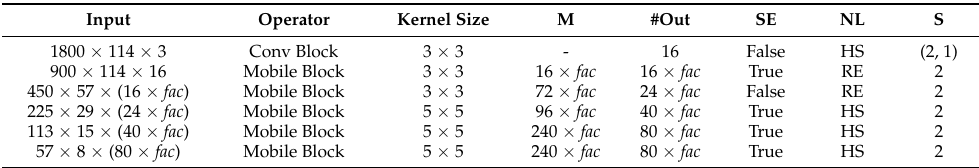
Table 3. Specifications for the feature extraction